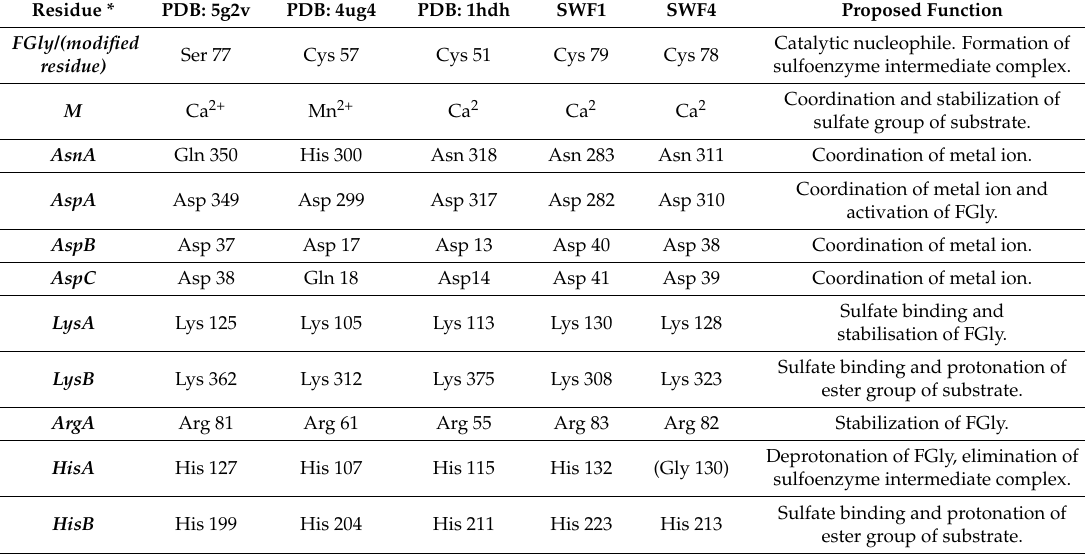
Table 1. Structure-based comparison of sulfate-binding S -subsites amino acid residues for several known sulfatases structures and fucoidan sulfatases SWF1 and SWF4.